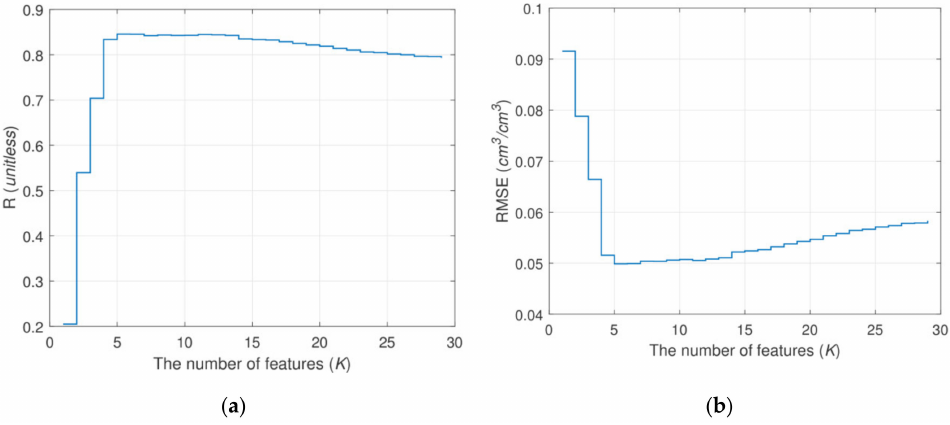
Figure 6. Step diagrams of ( a ) R and ( b ) RMSE based on MDA as a function of the number of features.